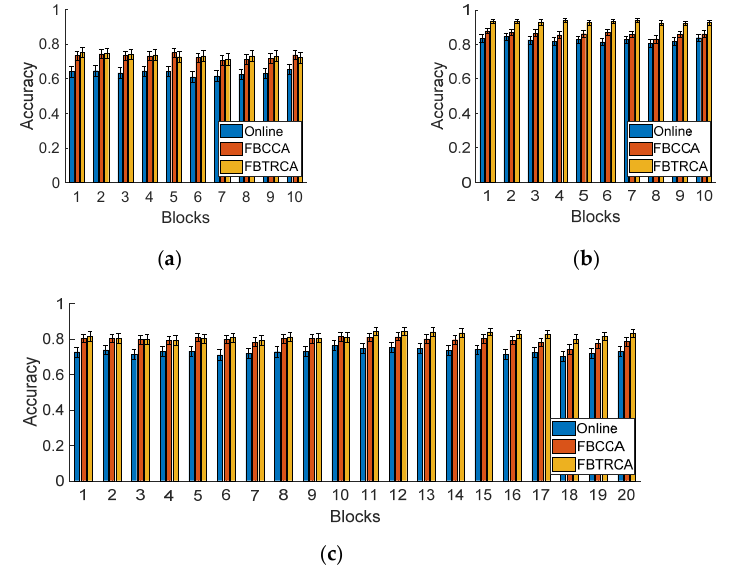
Figure 11. Online and offline (with FBCCA and FBTRCA methods) accuracy with ( a ) the dry-elec- trode headband, ( b ) the wet-electrode headband, and ( c ) both headbands over all data blocks.